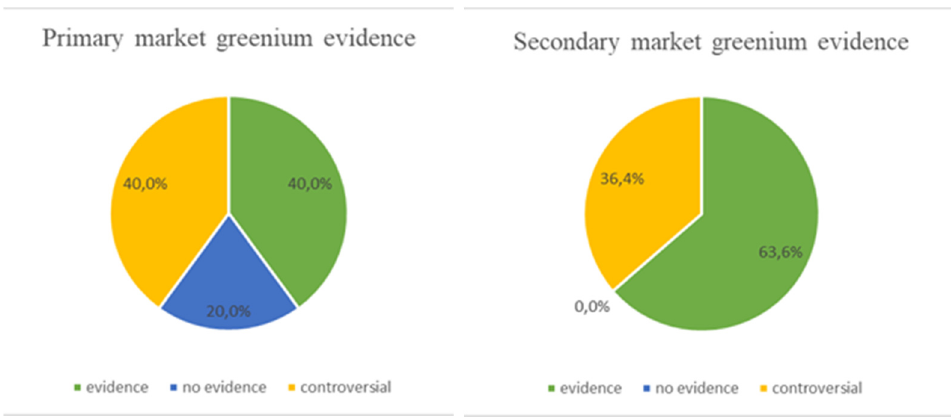
Figure 6. Greenium evidence within market segments.